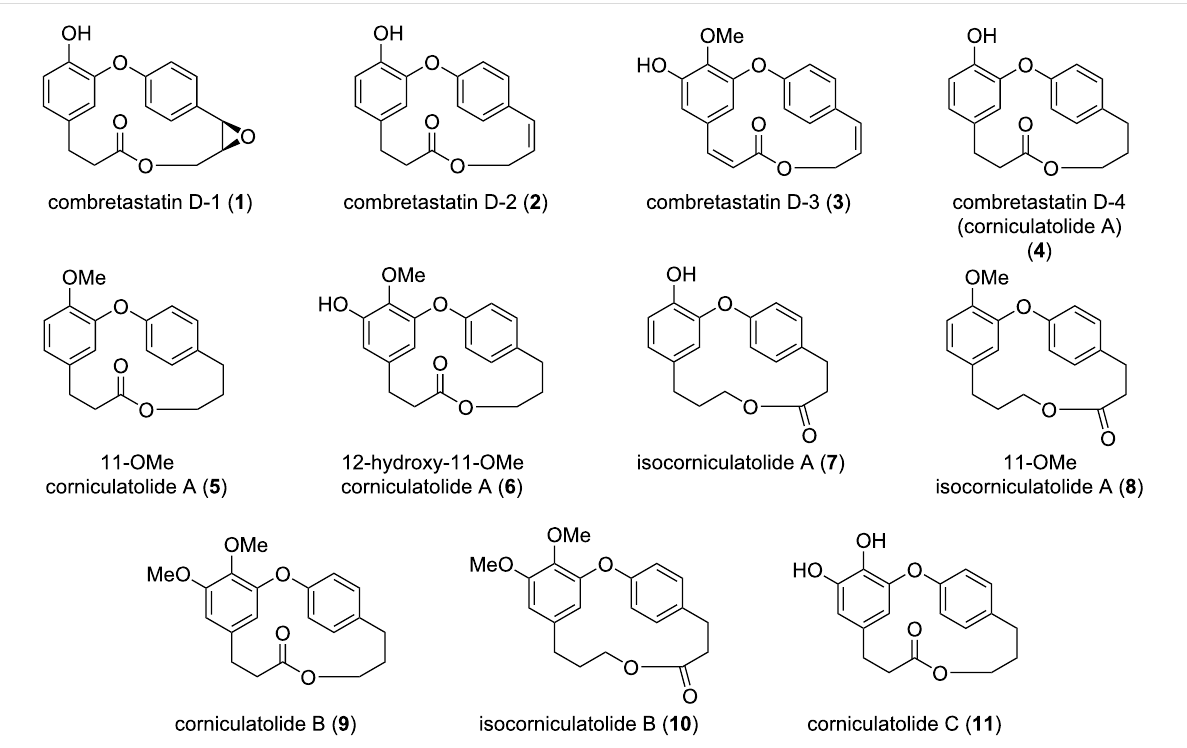
Figure 1: Structures of some members of the combretastatin D series, corniculatolides, and